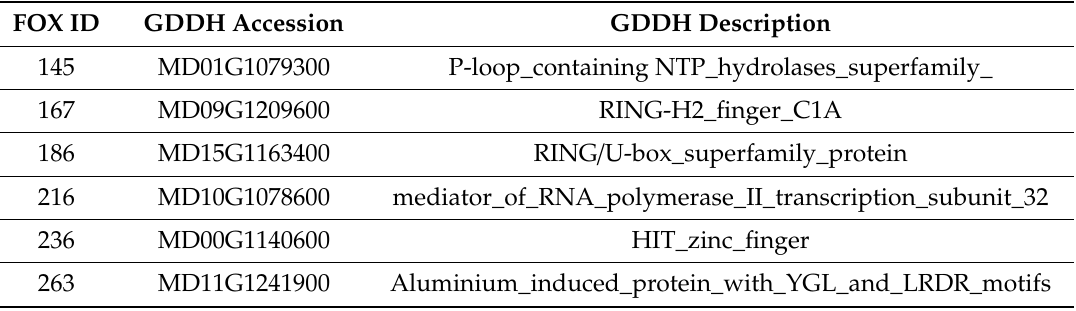
Table 1. GDDH accessions and gene descriptions of lines depicted in Figure